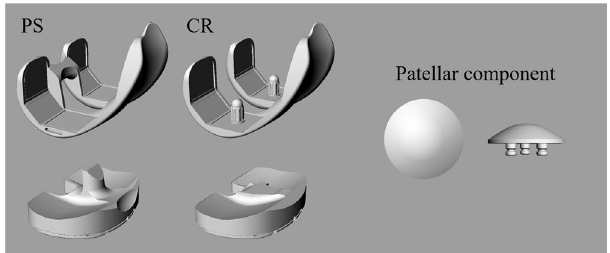
Figure 1. Cruciate-retaining and posterior-stabilized designs total knee system. CR Cruciate-retaining design, PS posterior-stabilized